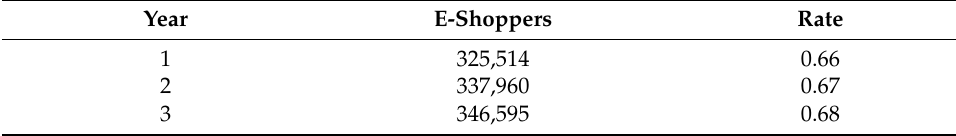
Table 5. E-shoppers results for each year.